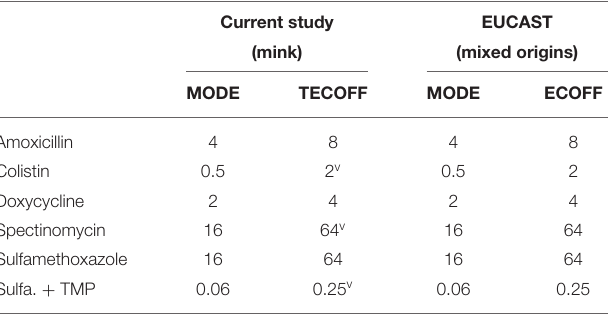
TABLE 2 | Escherichia coli isolated from mink—tentative ECOFFs and modes of MIC wildtype distributions and the official ECOFFs from EUCAST. Current study EUCAST (mink) (mixed origins)